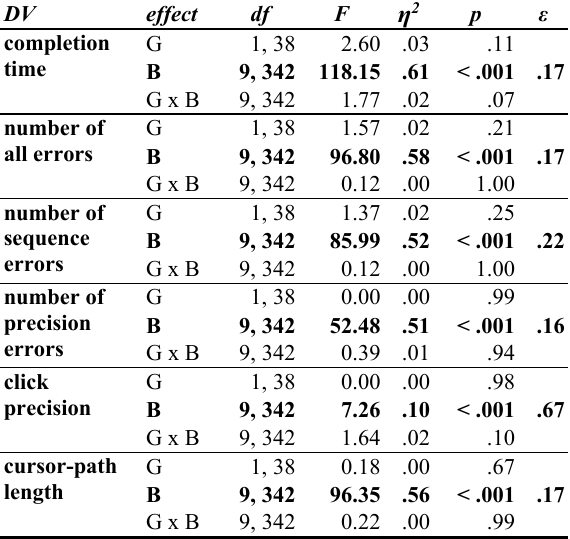
Table 9. ANOVA results of the recall phase of Experiment 5.